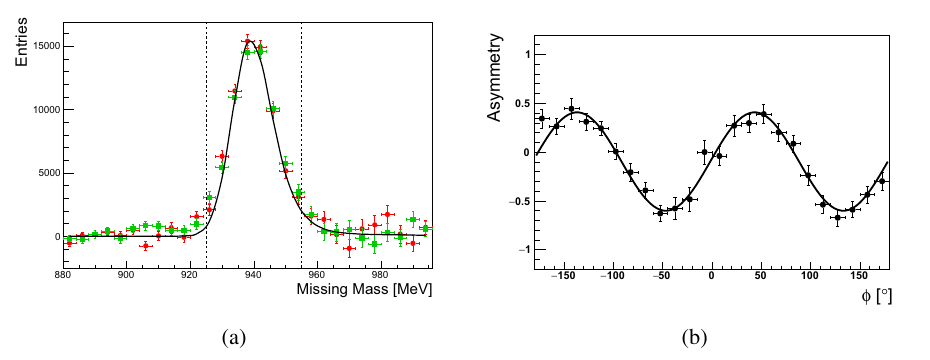
Figure 1: (a) Preliminary missing mass spectra for E γ = 100 − 120 MeV and 30 ◦ < θ < 155 ◦ for the two polarization planes with a relative o ff set of 90 ◦ (red circles and green squares) compared with the Monte Carlo simulated distribution for Compton scattering events (solid black line). (b) Preliminary φ -distribution for E γ = 120 − 140 MeV and 80 ◦ < θ < 100 ◦ obtained from equation